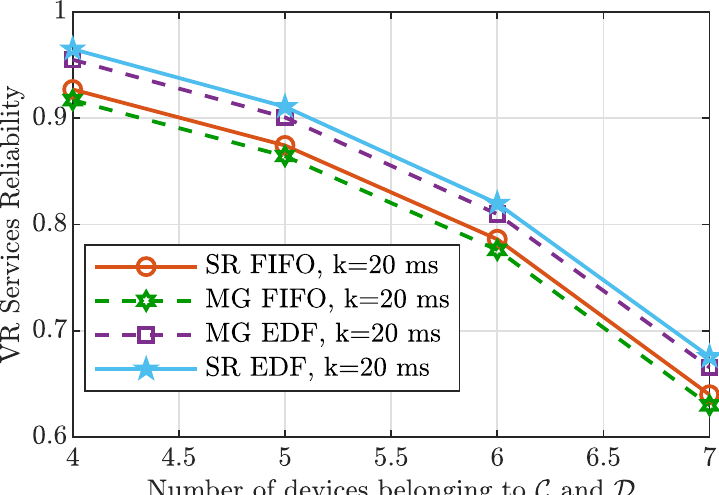
Figure 6. Reliability as a function of the number of devices belonging to C and D , considering p H = 0.014, p G = 0.01, and p c , p d =